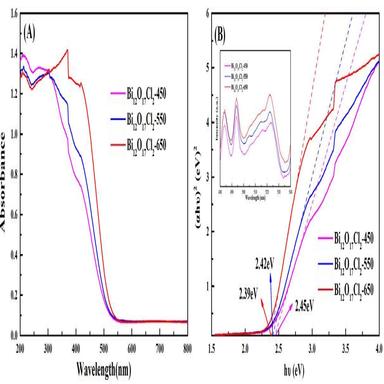
UV–Vis diffuse reflectance spectra of different Bi12O17Cl2 samples (A), and band-gap energy values determined via the plotted curve of (αhυ) 2 versus hυ and photoluminescence spectra (inset) (B).